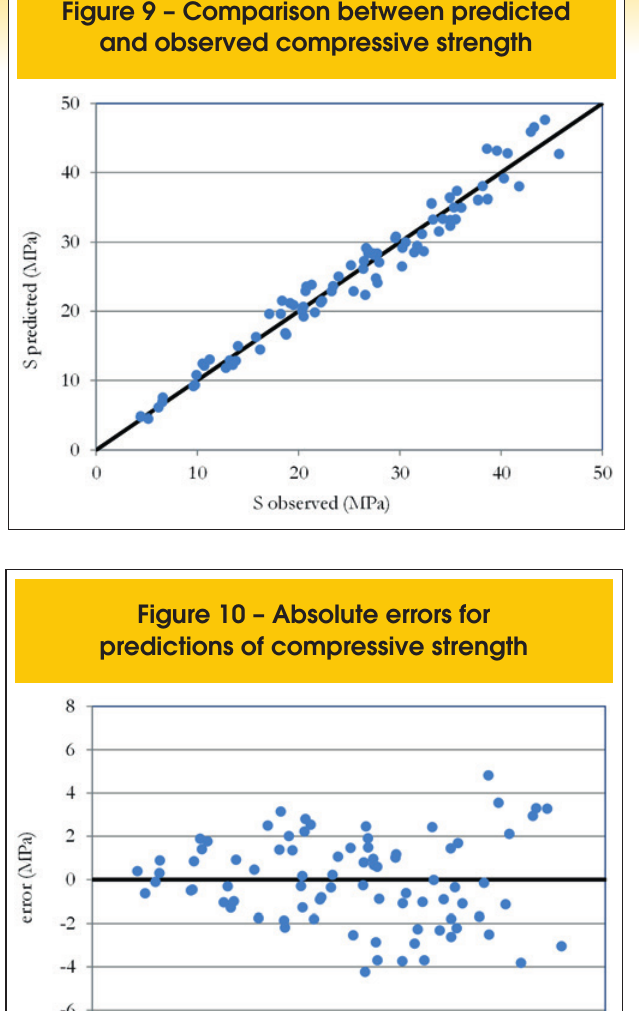
Figure 11 – Normalized errors for predictions of compressive